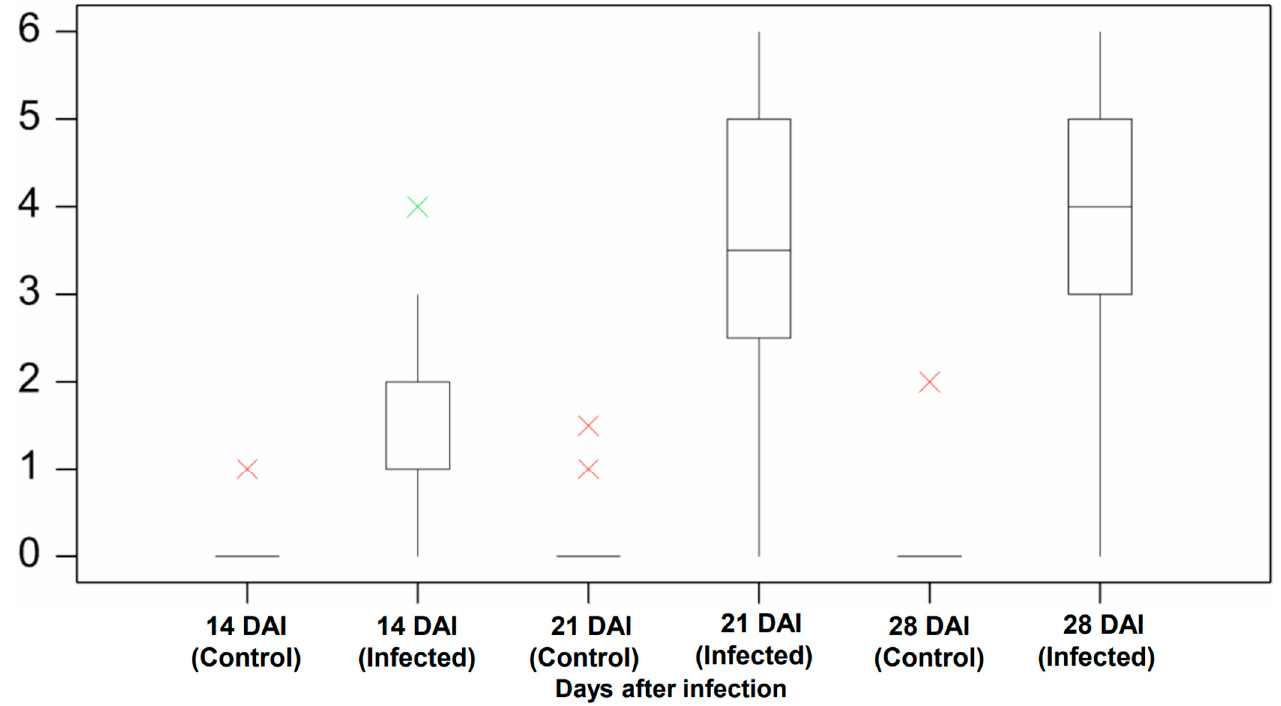
Figure 4. Manual screening result of the control and infected group. Compares the severity level between the control and infected group at 14, 21, and 28 DAI. The boxplot shows the disease severity level in the median, lower, and upper quartile value with interval, as well as the minimum and maximum value. The green cross is the outlier, and the red cross is the extreme outlier. Analysis was undertaken in Genstat (VSN International).